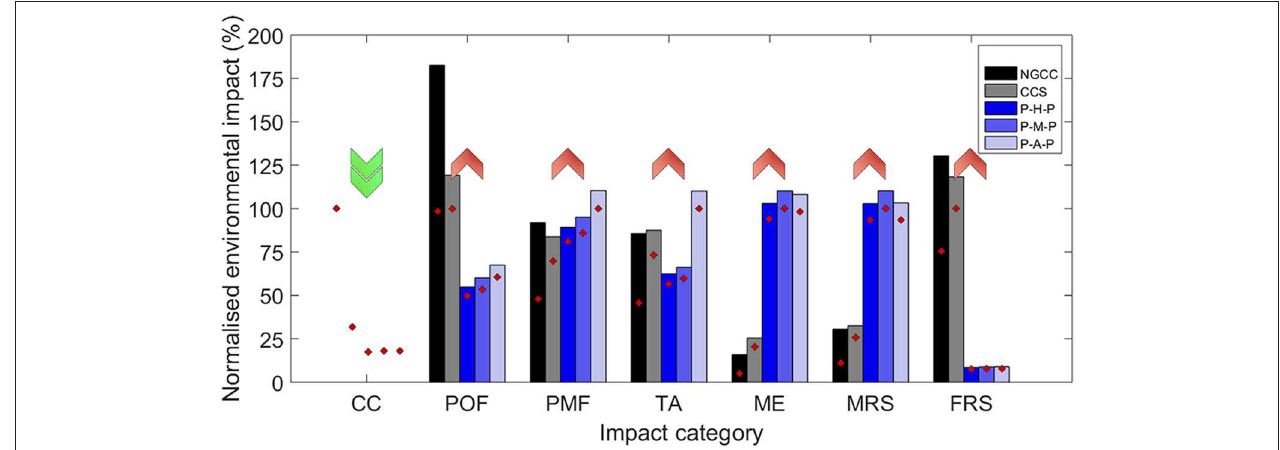
FIGURE 12 | Change in environmental impact per kWh dispatchable electricity if DAC is also used to fully negate the GHG emissions of background processes. The bars show the increased environmental impacts of the zero GHG emission systems; the diamonds give original values from the net-zero-direct-CO 2 -emissions systems in Figure 8 . Arrows show whether there is an increase or decrease of the impact compared to the case where only the foreground emissions were abated. A value of 100% represents the system with the highest environmental impact on that impact